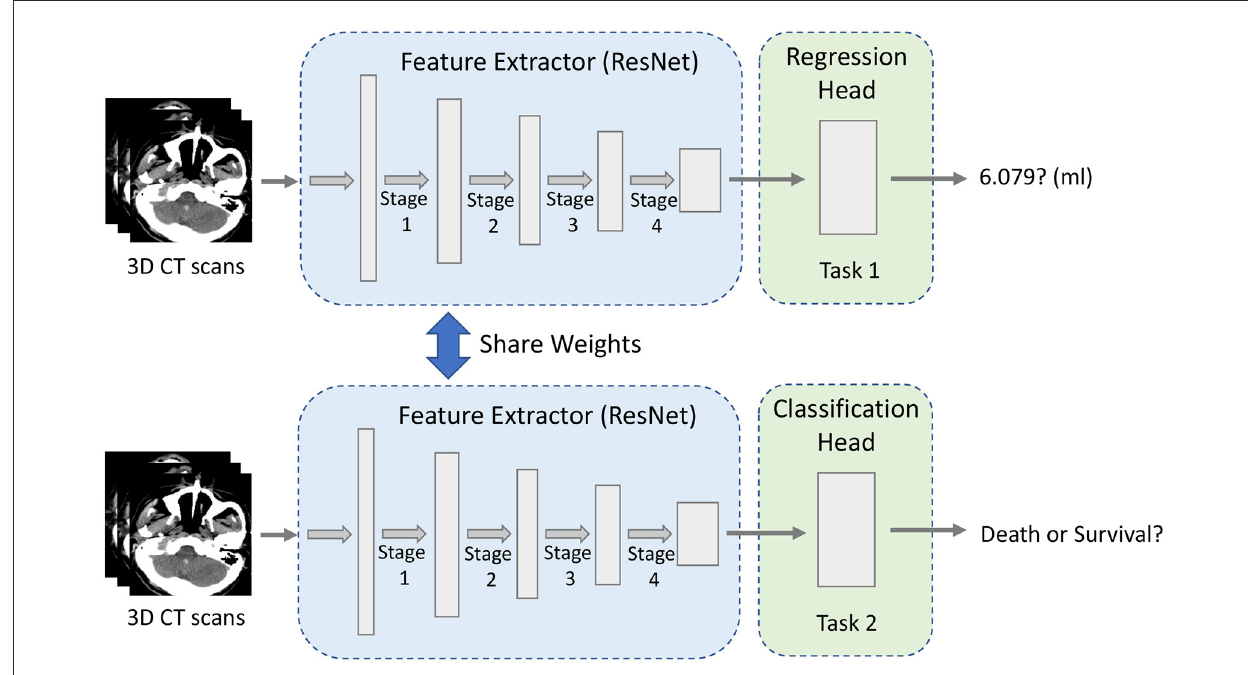
FIGURE1 The overview of our multi-task framework.